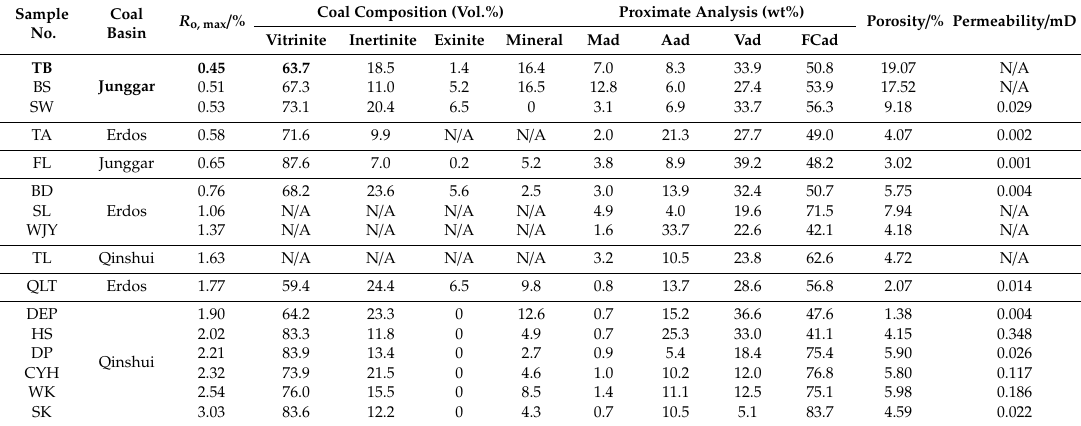
Table 1. Routine test information of experimental coal